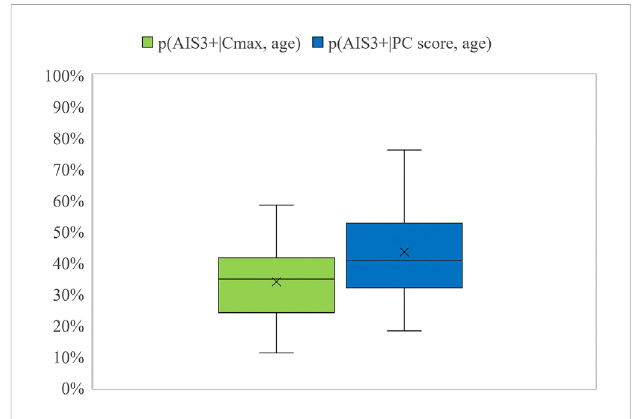
Box plot for the probability of AIS3+ calculated using Cmax and PC